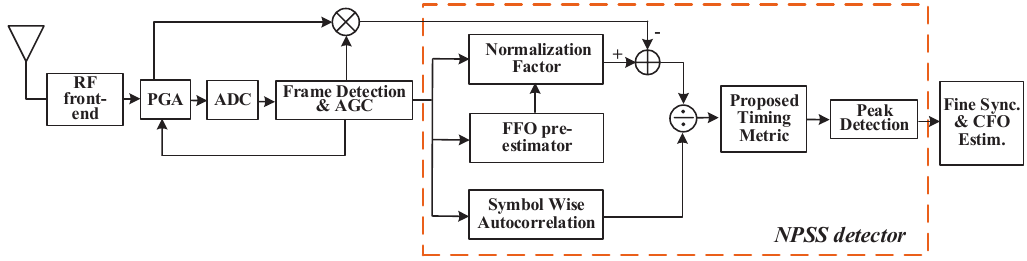
Figure 5. Block diagram of the proposed NPSS detector